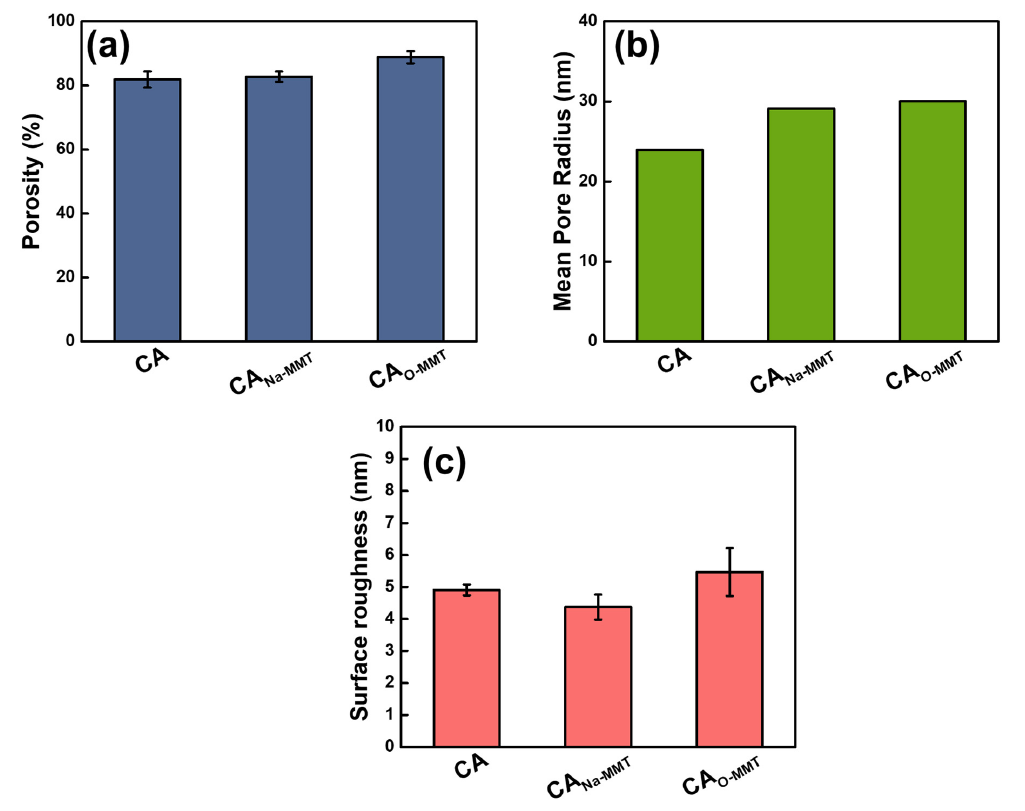
Figure 3. ( a ) Bulk porosity, ( b ) mean pore radius, and ( c ) surface roughness of the CA and modified membranes.